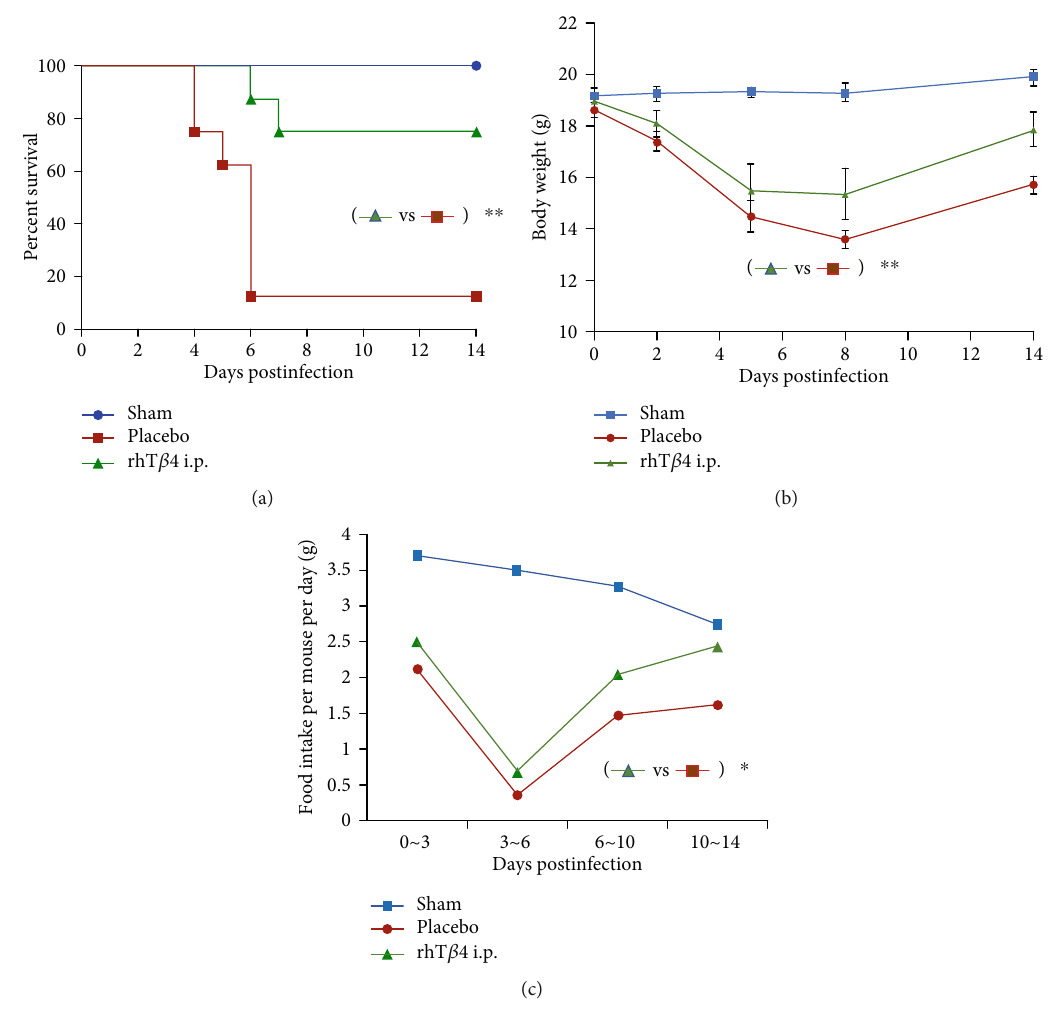
Figure 2: Protection of rhT β 4 i.p in BALB/c mice by infection of MHV-A59. (a) The survival rate of mice in group sham, placebo, and rhT β 4 i.p ( n = 8 per group). Log-rank (Mantel-Cox) test was used to analyze the statistical di ff erence between groups. ∗∗ P < 0 : 01 . (b) Change of body weights was monitored at 2, 5, 8, and 14 d.p.i. Two-way ANOVA was used to compare two group data. ∗∗ P < 0 : 01 . (c) Food intake of the survived mice in each group was calculated during 0 ~ 3, 3 ~ 6, 6 ~ 10, and 10 ~ 14 d.p.i. Two-way ANOVA was used to compared two group data. ∗ P < 0 : 05 .